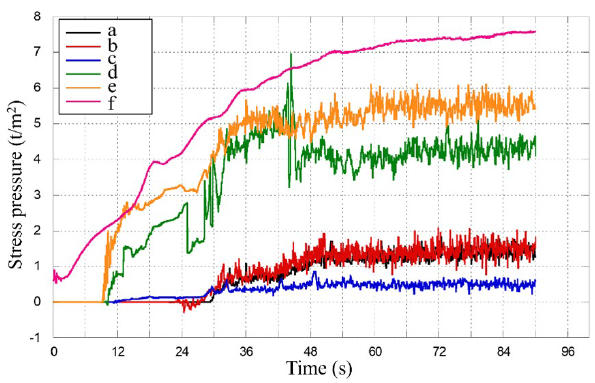
Figure 32. Loading variation stress as a function of time at points a–